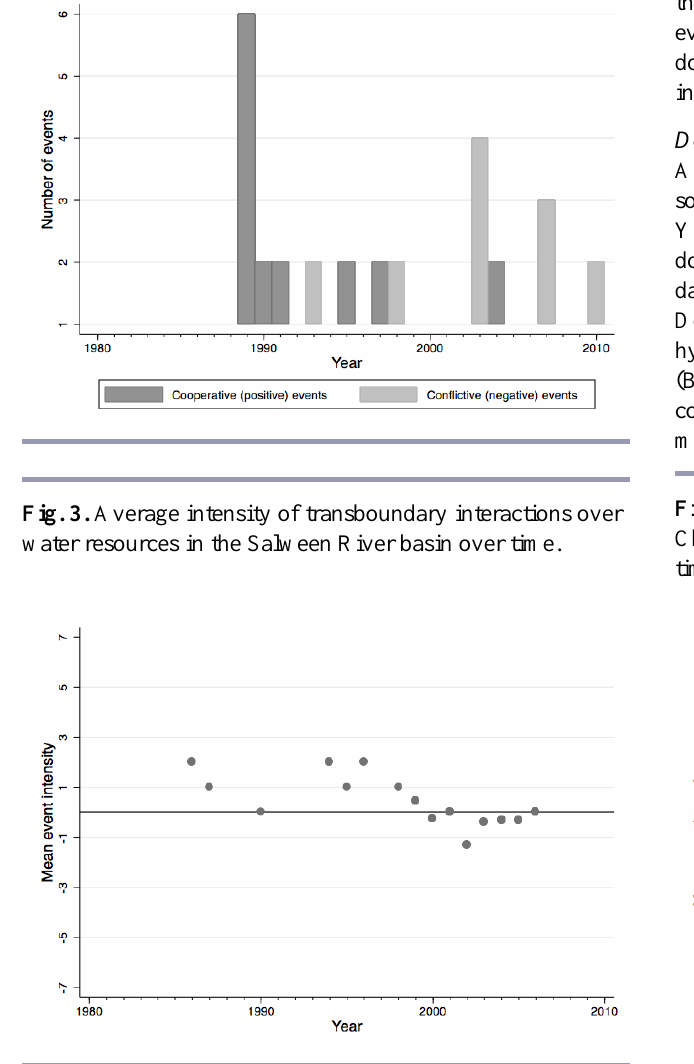
Fig. 2. Number of conflictive and cooperative events per year in the Salween River basin.